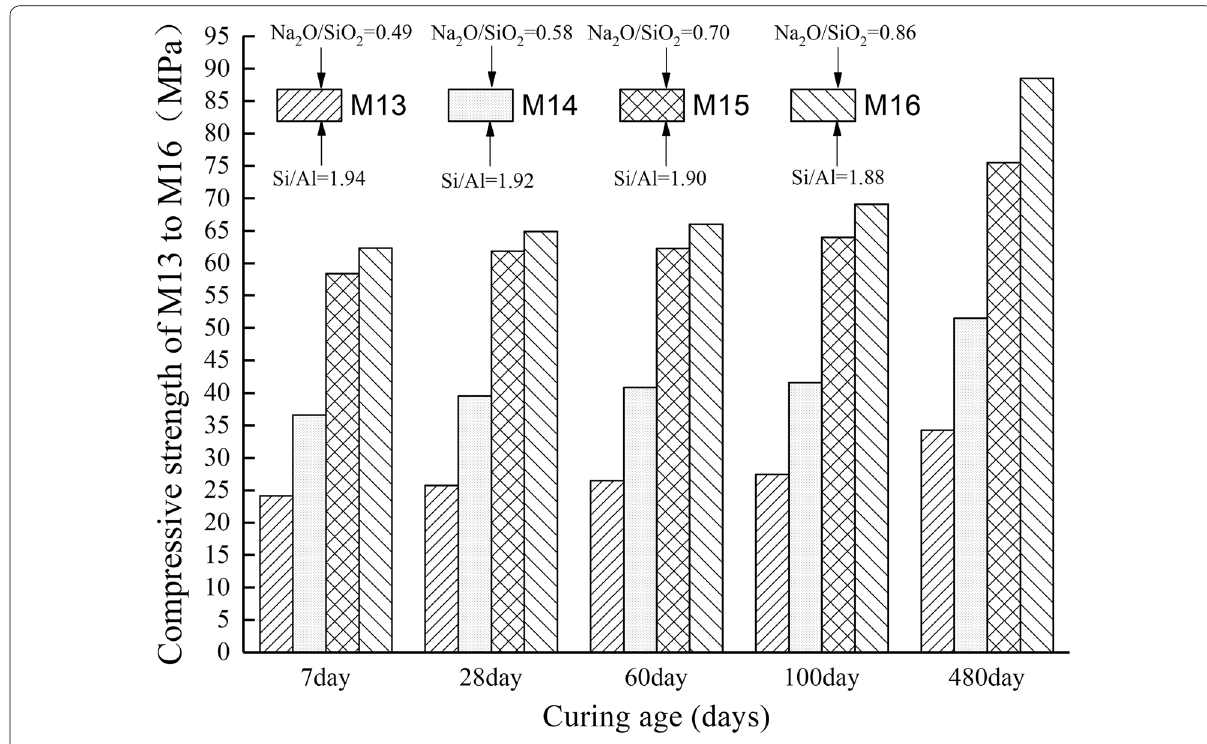
Fig. 7 Compressive strength of M13 to M16 and their Si/Al and Na 2 O/SiO 2